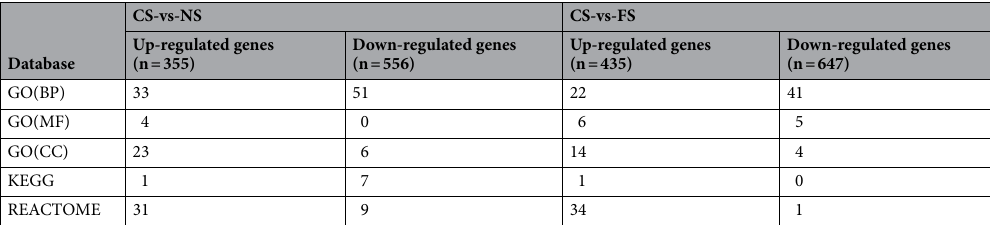
Table 1. Number of enriched terms in different categories of enrichment analyses in comparisons of current versus never smokers (CS-vs-NS) and current versus former smokers